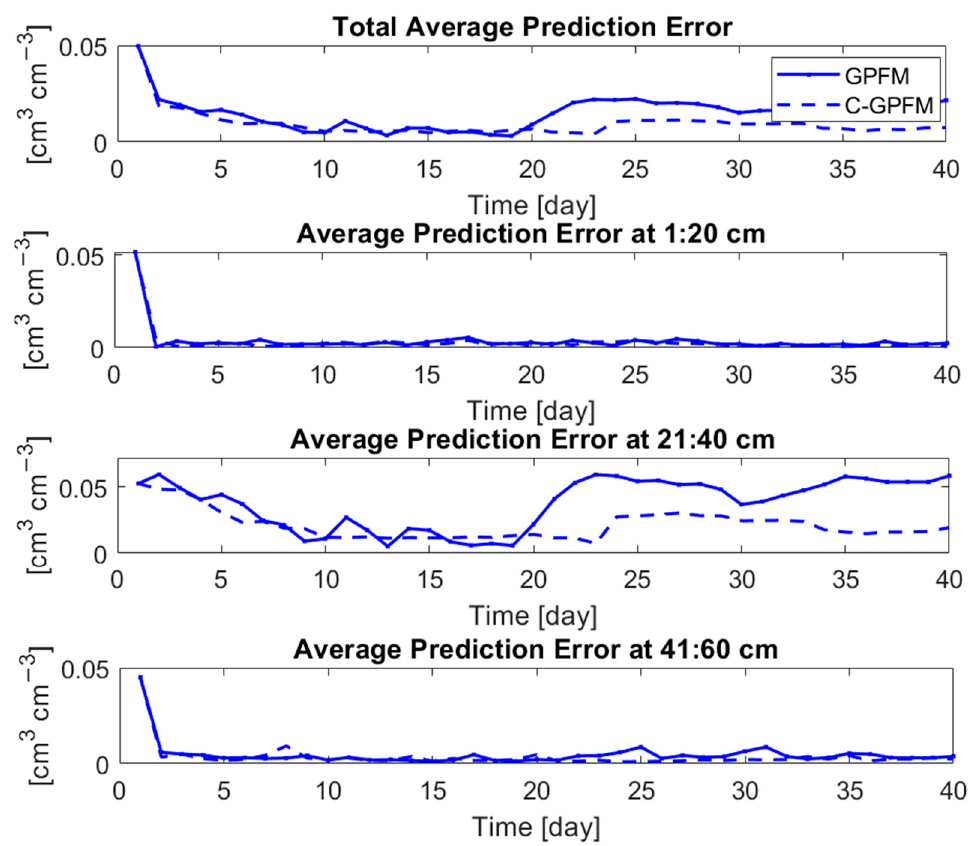
Figure 6. Average of state prediction error for the next 20 days at each day of assimilation by C-GPFM and GPFM for Case Study #1.